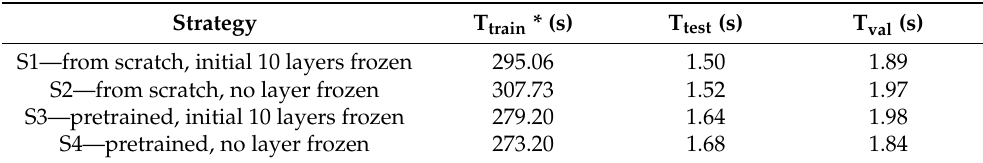
Table 8. Assessment results of computational time of the GoogLeNet model using different training strategies.